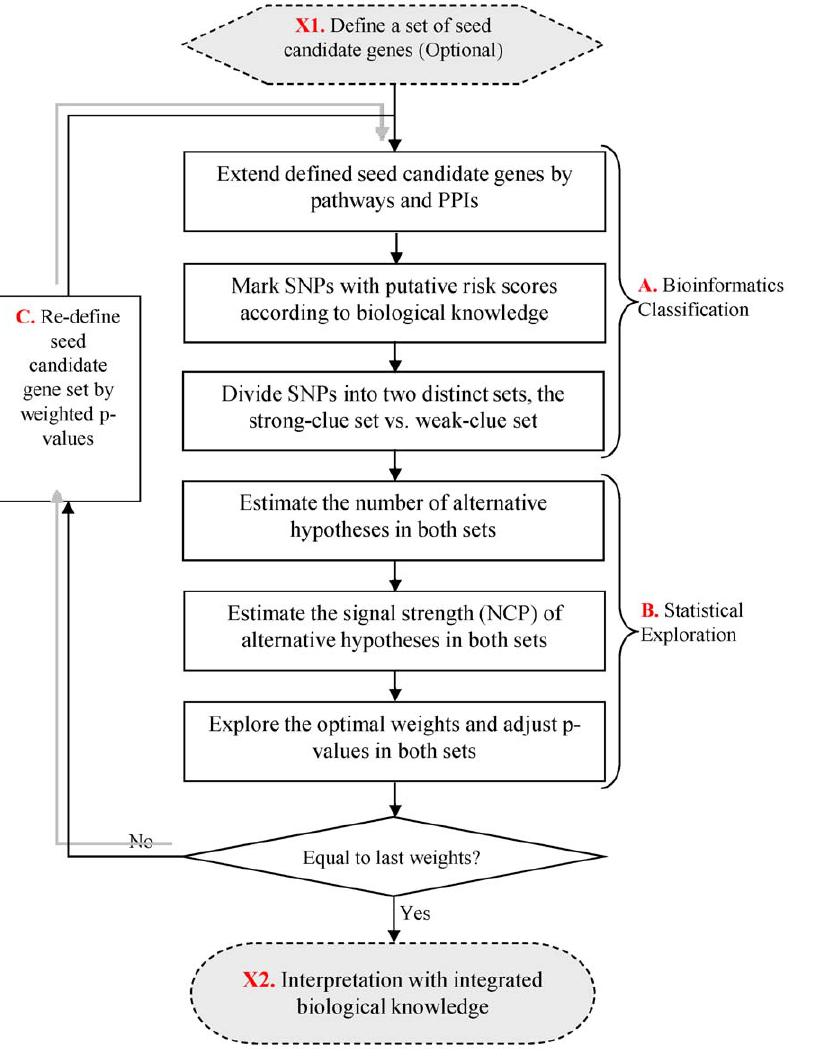
Figure 1. Flow diagram showing the weighting procedure of the bioinformatics and statistical integration framework. In the figure, Step A, B and C constitute the kernel part of the procedure. They run iteratively. In Step A, SNPs are classified into two distinct sets (a strong-clue set and a weak-clue set) based on biological knowledge integrated from various bioinformatics databases. In Step B, a statistical exploration is conducted to adjust p- values of SNPs by optimal weights that are in favor of the strong clues. In Step C, the top- n (say, Top-10) genes according to the weighted p- values are selected to form a new set of seed candidate genes. The iteration stops when the weights in the current iteration are equal to the ones in the last iteration. X1 and X2 are auxiliary steps. In Step X1, one can define a set of important seed candidate genes for the disease in question. However, this step is optional. If there is no pre-defined seed candidate genes, the top- n (say, top-20) genes according to the original association p- values are picked up to form a new set of seed candidate genes. In Step X2, biological knowledge of the highlighted SNPs can be specifically retrieved to interpret the association significances under the framework.